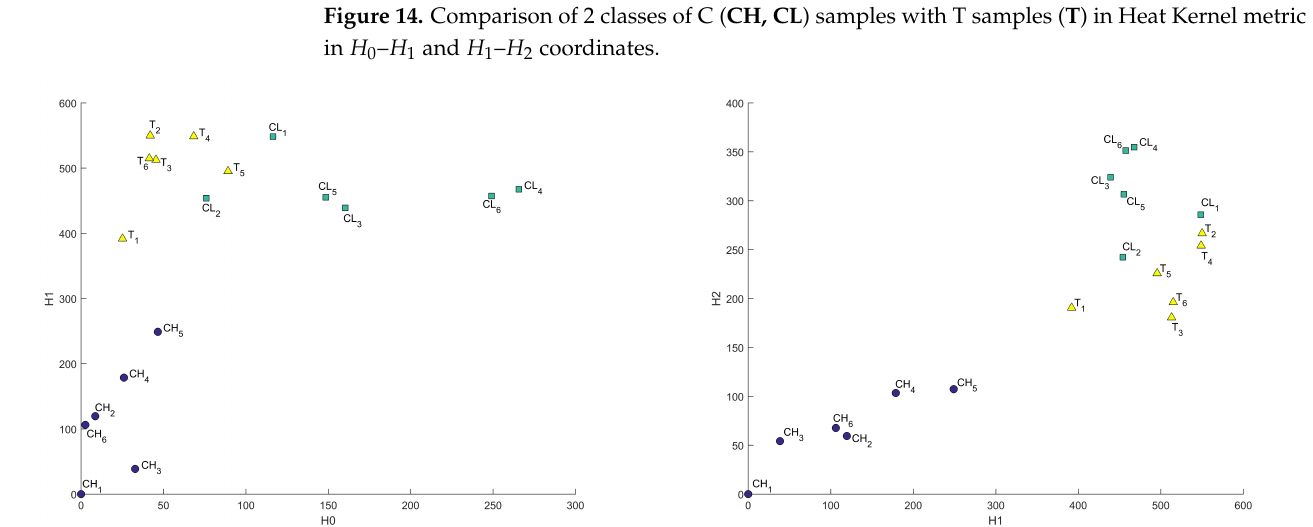
Figure 15. Comparison of 2 classes of C ( CH, CL ) samples with T samples ( T ) in Sliced Wasserstein metric in H 0 – H 1 and H 1 – H 2